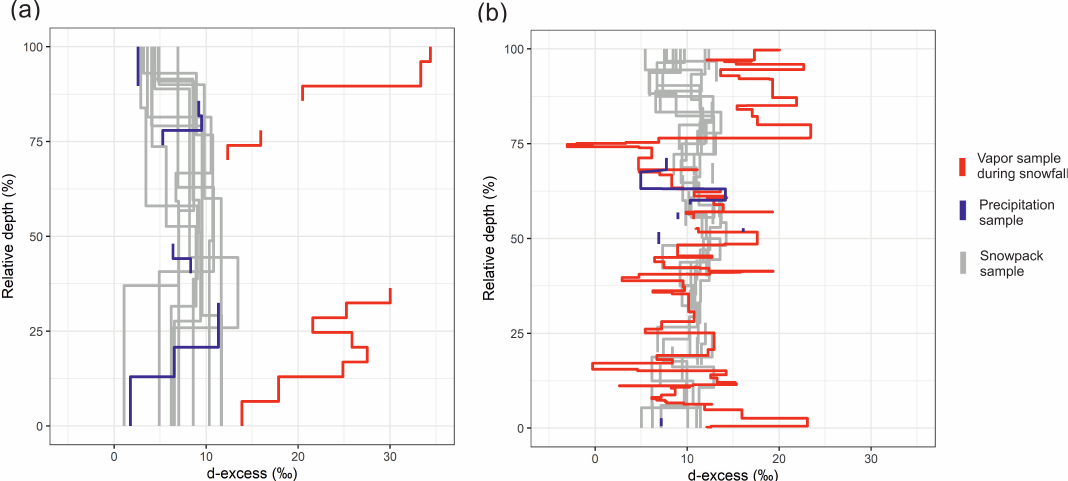
Figure 10. Accumulated atmospheric vapor d-excess composition (red) during days with snowfall and accumulated precipitation isotope profiles (blue) superimposed on the snowpack isotope profiles (gray) for ( a ) Imnavait and ( b )